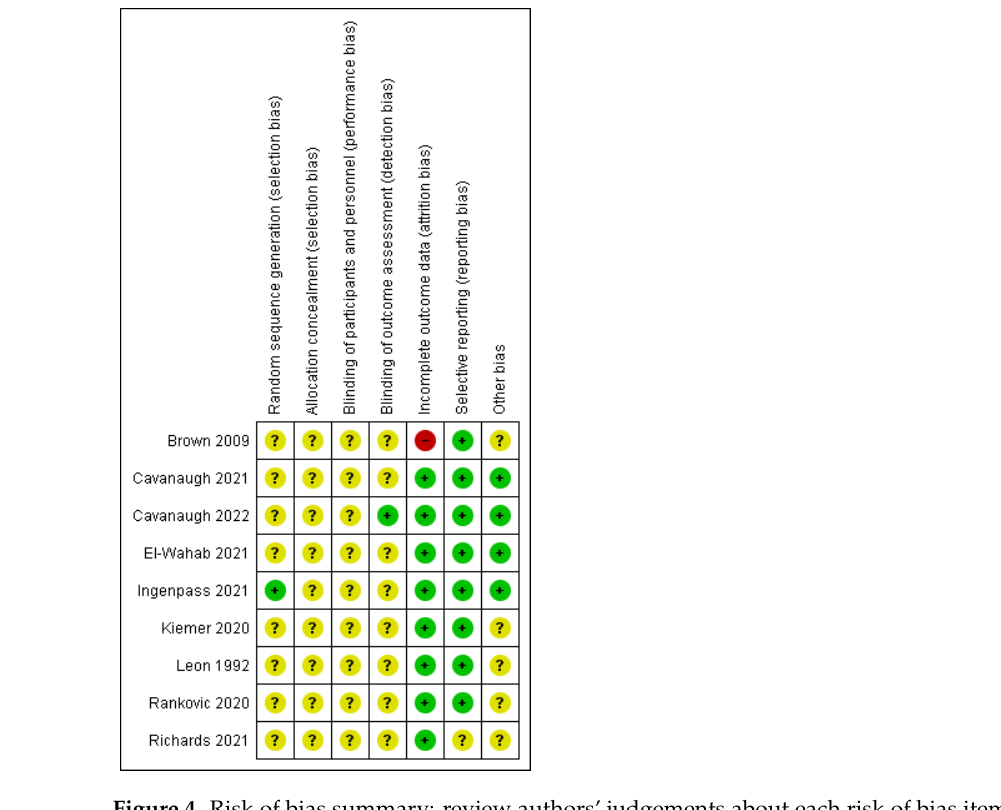
Figure 4. Risk of bias summary: review authors’ judgements about each risk of bias item for each included study [17,29,33 – 39].